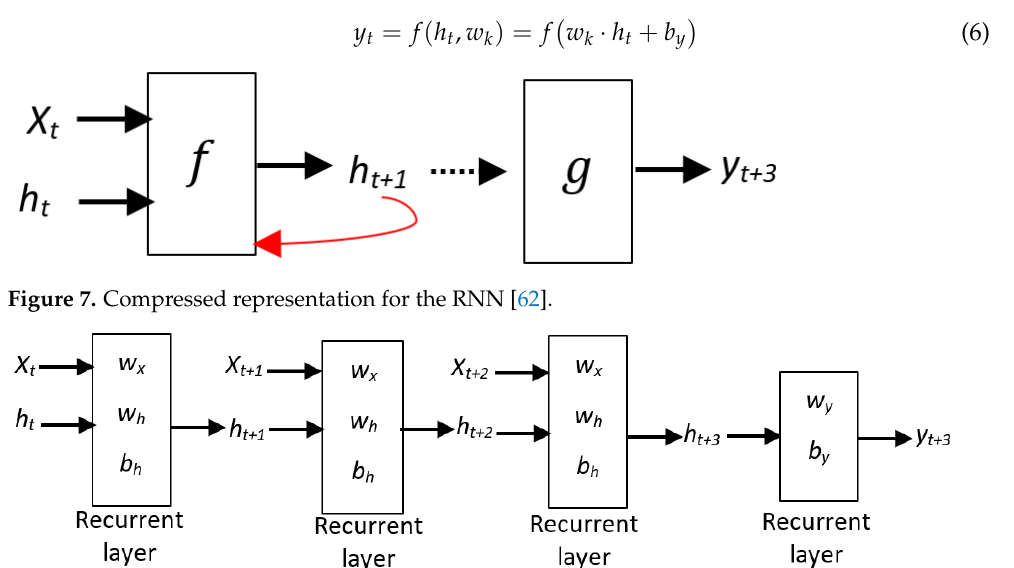
Figure 8. Unfolded network representation for the the RNN